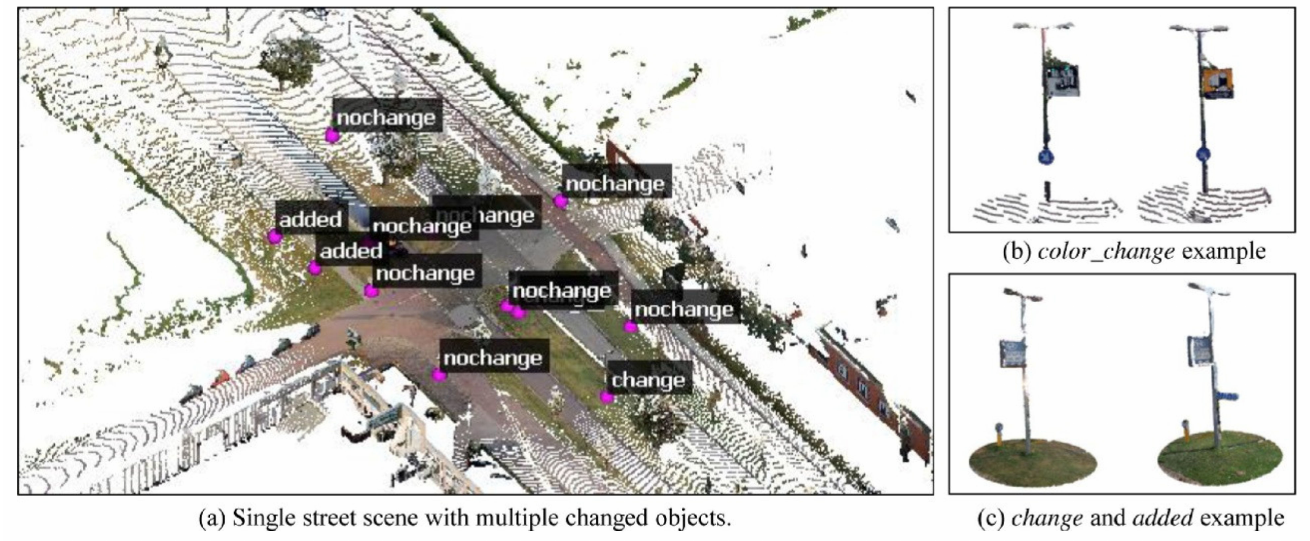
Figure 15. Change3D dataset with labeled points and two examples of change in color and addition. Source: Image adopted from [121].